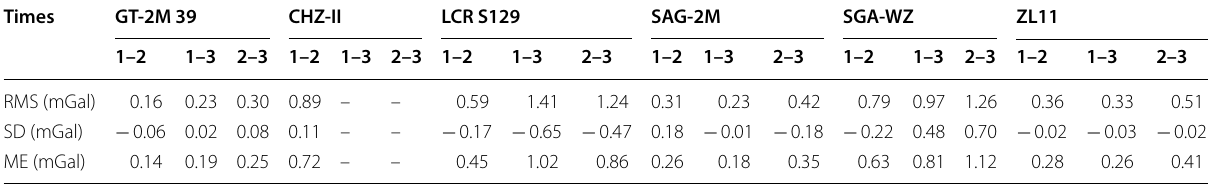
Table 3 Error statistics of different gravimeters on the repeated line L2 Times GT-2M 39